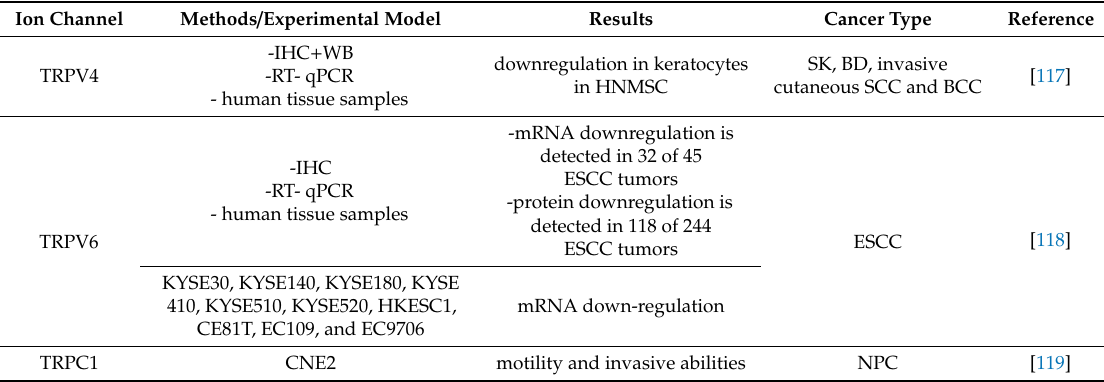
Decreased expression of TRP channels in human head-and-neck cancer samples and